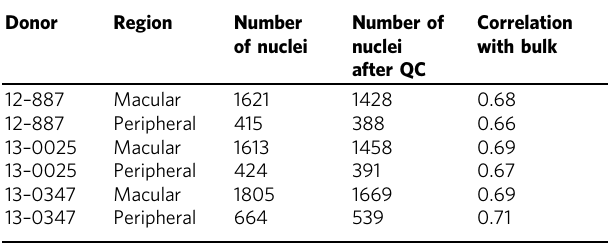
Table 2 Basic sample information showing nuclei numbers and correlation with bulk RNA-seq of the same